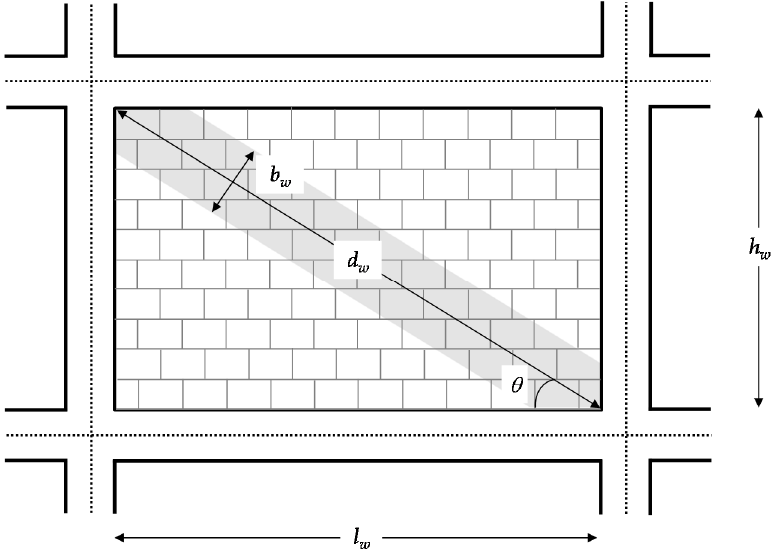
Figure 1. Infill geometric notations adopted in this study.